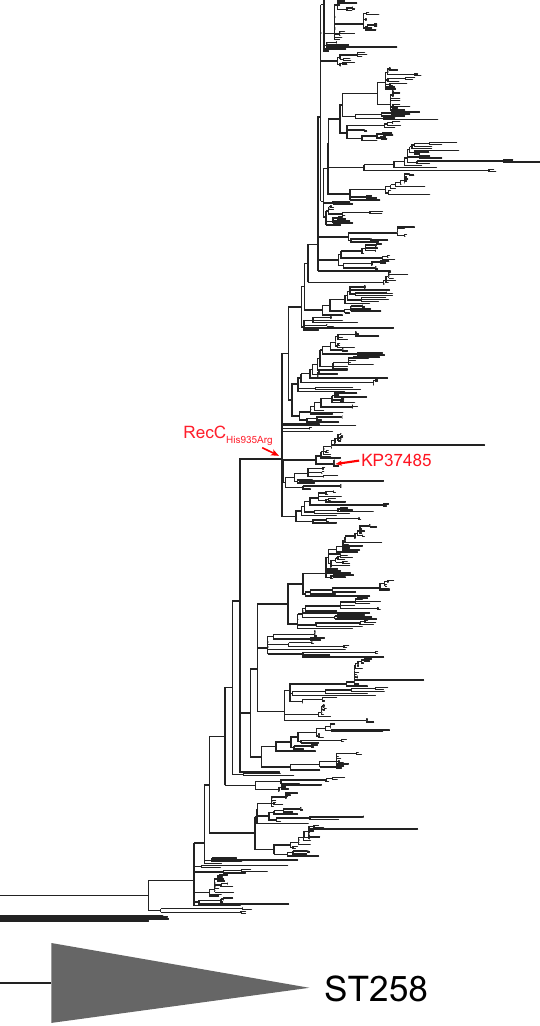
Fig. 2 | Phylogenetic analysis of646 CRKP-ST11isolatescollectedinthis study. The phylogenetic tree was obtained by mapping all sequence reads to the hybrid assembly of an ST11-OL101:KL47 isolate (KP16932) and removing the recombined regionsfromthealignment.ThetreewasrootedusingtheST258outgroupisolates (gray triangle). Thirteen O/K combinations were detected in our ST11 collection, which areindicated in different colors, asshown in the legend.The hypervirulence biomarkers detected (except for iro due to its rarity in our collection) are shown here.TheARGs[ bla LAP-2 , dfrA -like, qnr -like, sul -like, tet(A) ,and oqxAB ]detectedwith